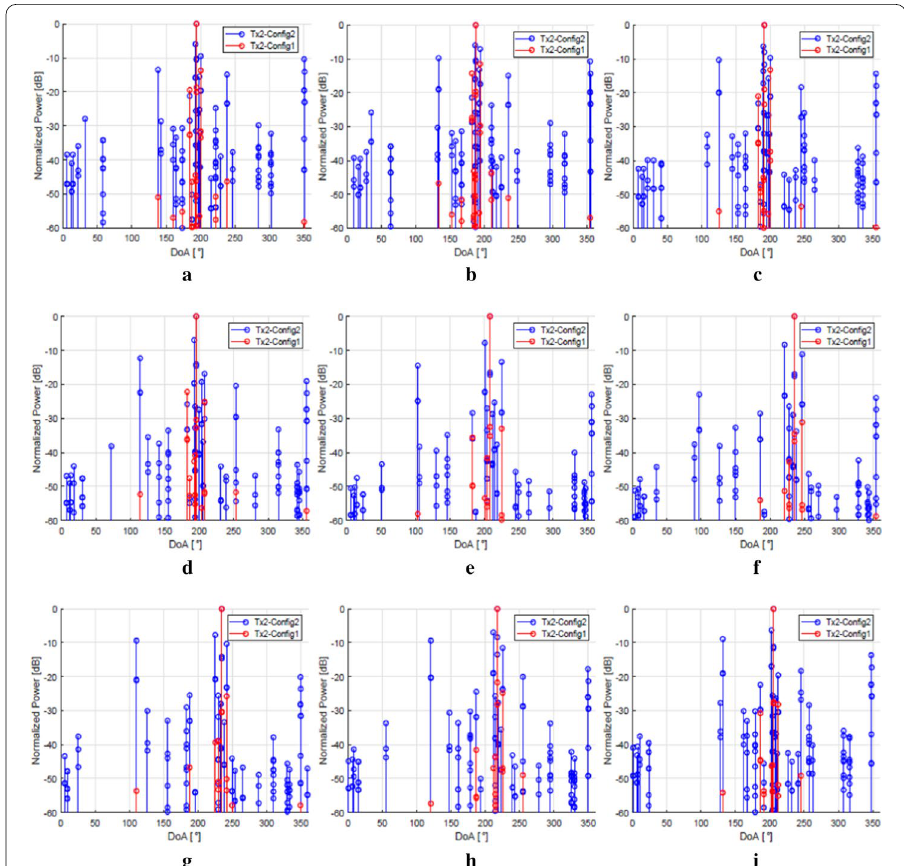
Fig. 17 Power angular profile with Tx2. a Pos 1, b Pos 2, c Pos 3, d Pos 4, e Pos 5, f Pos 6, g Pos 7, h Pos 8, and i Pos